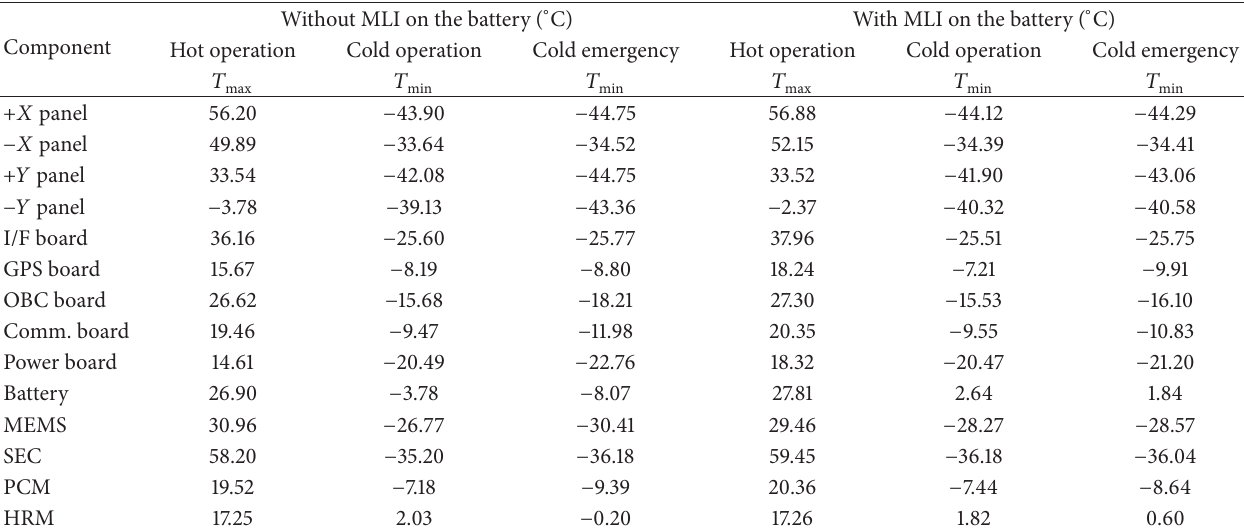
Table 10: On-orbit temperature prediction after thermal design modification on the battery.